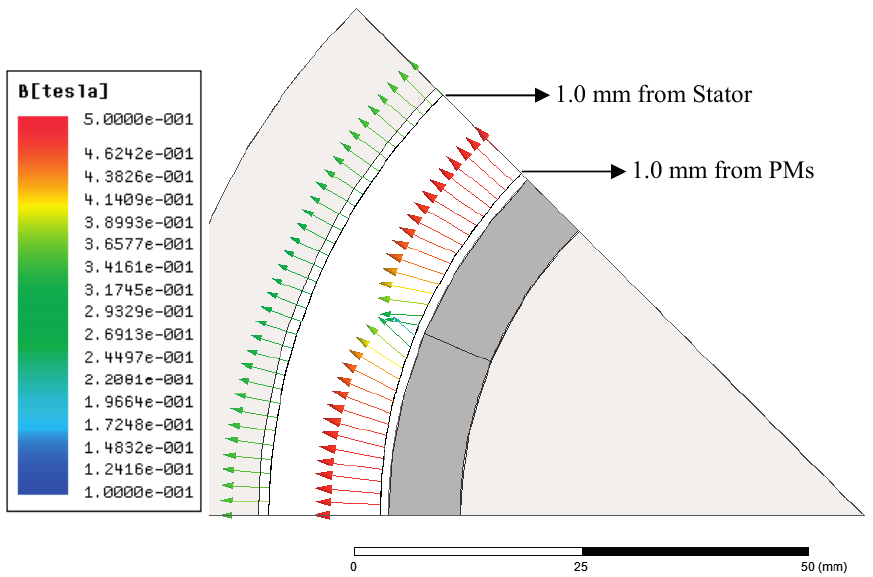
/2 of the vector B in the air gap at 1.0 mm from the permanent Figure 11. Axial view at τ m magnets and at 1.0 mm from the stator